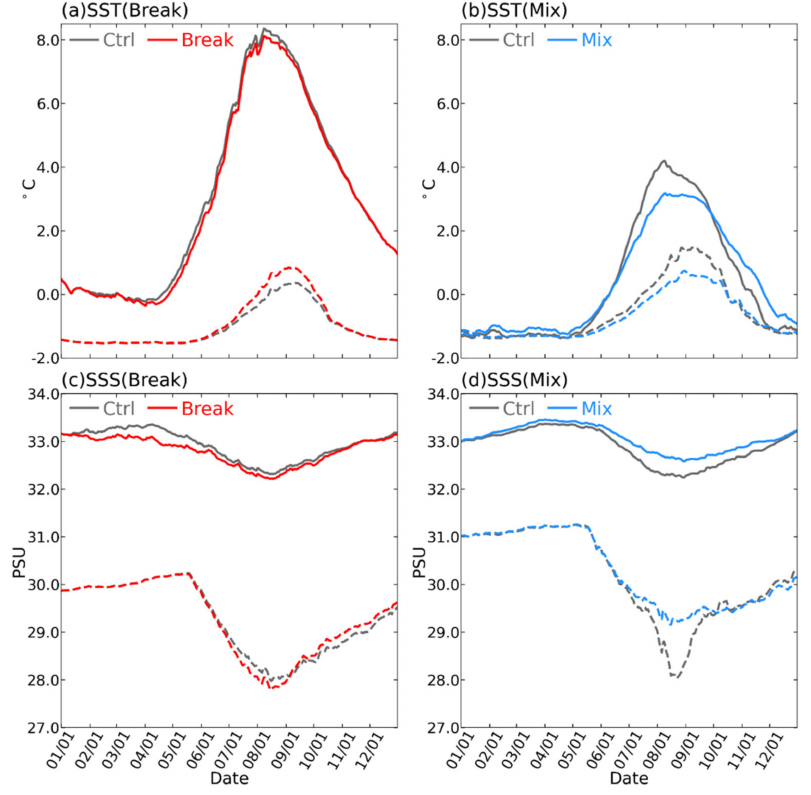
Figure 9. ( a ) Averaged sea surface temperature from the Ctrl (gray) and Break (red) experiments over the Break_Winter (solid line) and Break_Summer (dash line). ( b ) Averaged sea surface temperature from the Ctrl (gray) and Mix (blue) experiments over the Mix_Winter (solid line) and Mix_Summer (dash line). ( c , d ) Same as ( a , b ), but for the sea surface